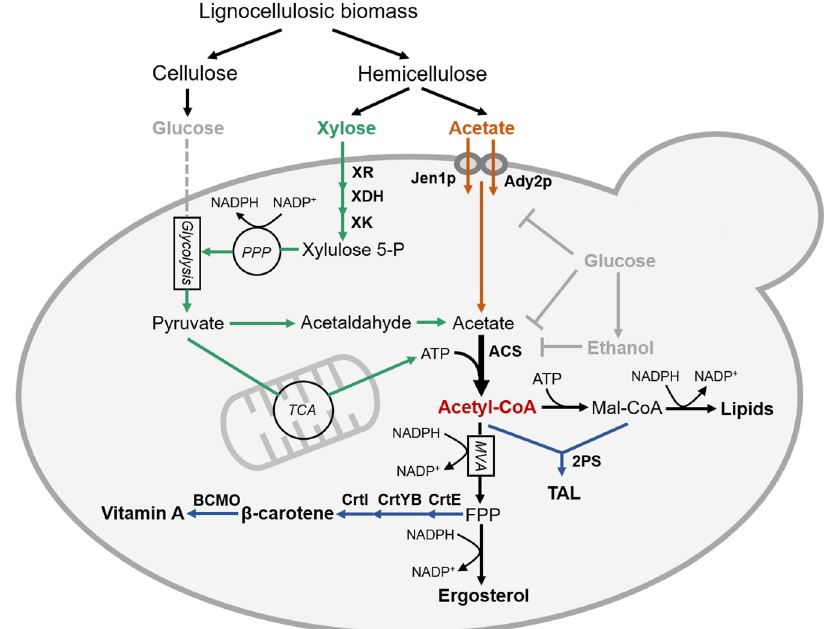
Fig. 1 Schematic diagram of the production of TAL and (pro-)vitamin A from hemicellulose fractions by engineered S. cerevisiae . Xylose is assimilated through the oxidoreductive pathway consisting of XR (xylose reductase), XDH (xylitol dehydrogenase), and XK (xylulose kinase). Acetate enters yeast cells through either Jen1p or Ady2p transporter and is converted into acetyl-CoA by ACS (acetyl-CoA synthase). TAL is synthesized through the condensation of acetyl-CoA and malonyl-CoA by 2PS (2-pyrone synthase). Heterologous expression of CrtE (GGPP synthase), CrtYB (bifunctional phytoene synthase, lycopene cyclase), and CrtI (phytoene desaturase) in S. cerevisiae allows the production of β -carotene which is then cleaved into vitamin A by BCMO ( β -carotene monooxygenase). Color code for arrows: gray, glucose metabolism; green, xylose metabolism; orange, acetate metabolism; black, other endogenous pathways; black in bold, reaction with strong fl ux; blue, heterologous TAL or vitamin A biosynthetic